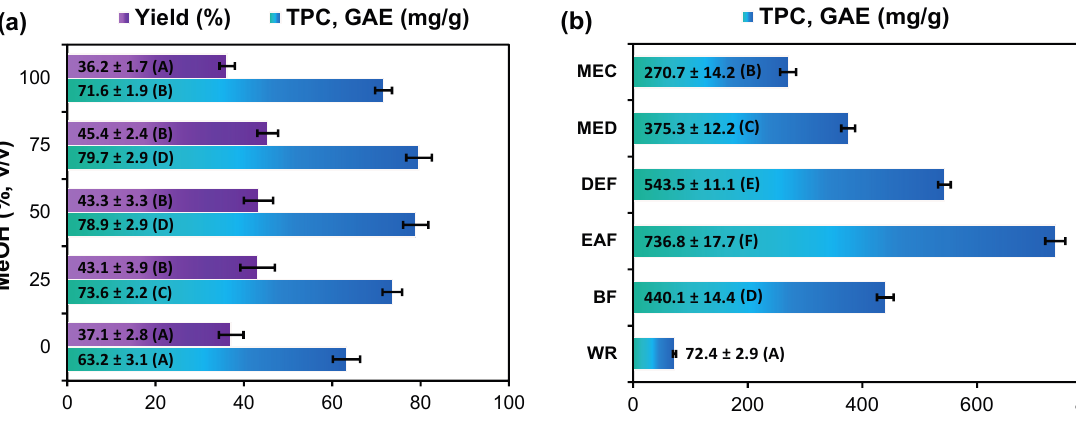
Figure 1. ( a ) Optimisation of the extraction process: yield and recovery of total phenolics from the leaf material dry weight; ( b ) Total phenolic content of dry leaf extracts